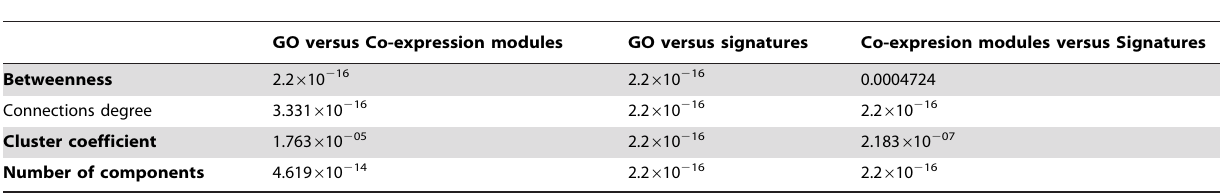
Table 4. P-values corresponding to the comparisons of distributions of network parameters across several module definitions by means of a two-tailed Kolmogorov-Smirnov